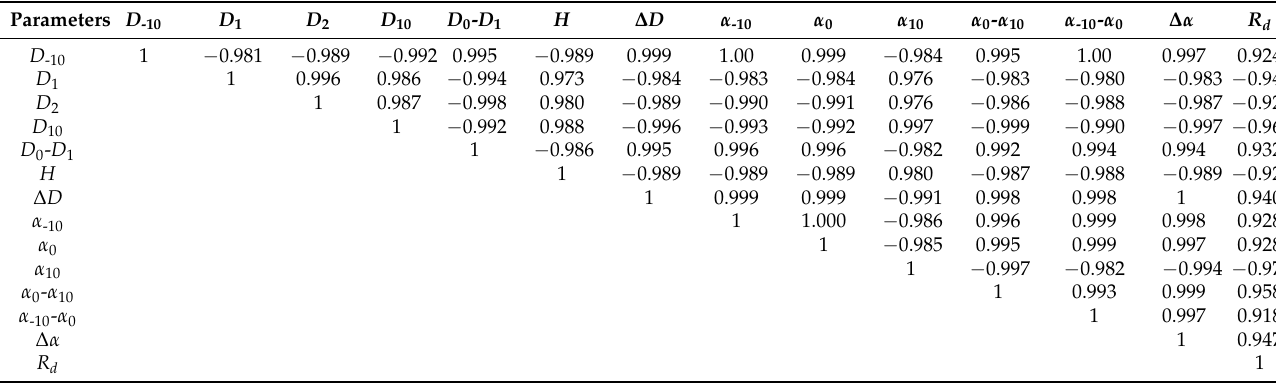
Table 3. Correlation analysis of multifractal